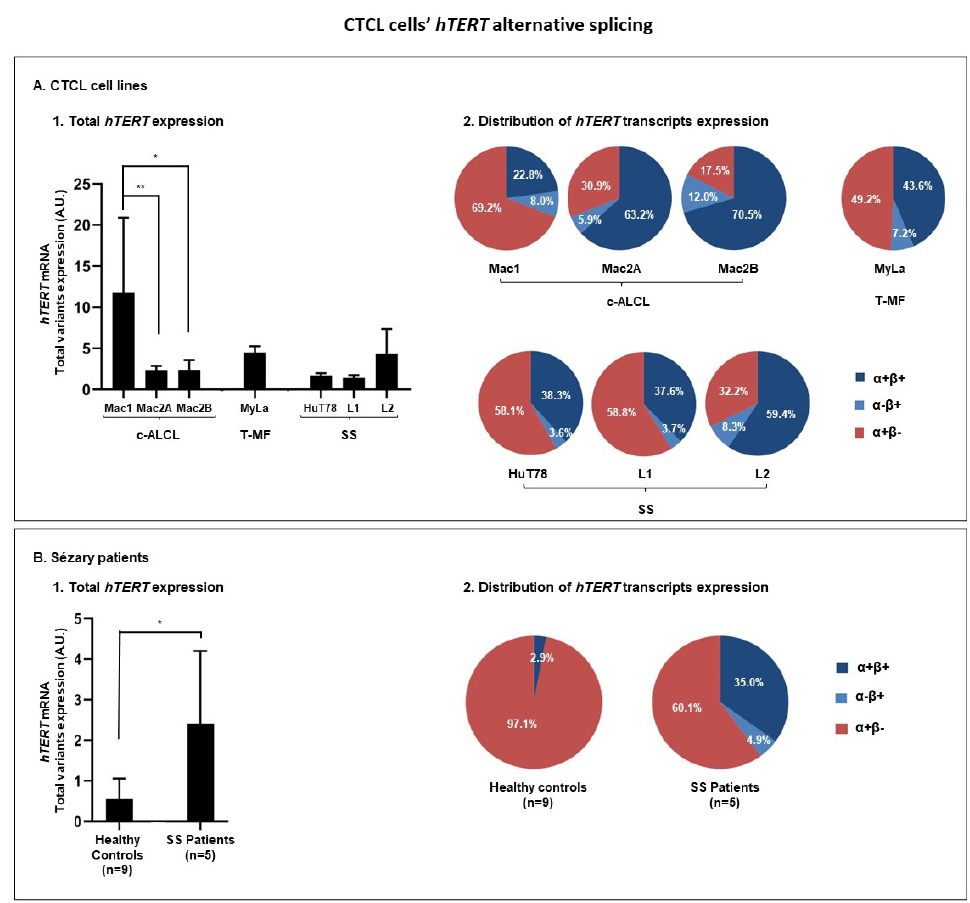
Figure 3. CTCL cells’ hTERT alternative splicing. ( A ) hTERT RT domain transcriptome analyzed in CTCL cell lines representative of different CTCL subtypes: Mac1, Mac2A, and Mac2B for c-ALCL, MyLa for T-MF, and HuT78, L1 and L2 for SS. ( A1 ) hTERT transcripts expression levels. ( A2 ) Distribution of hTERT transcripts expression. β + variants are presented in blue and β - variants in red. ( B ) hTERT RT domain transcriptome analyzed in peripheral blood mononuclear cells from five SS patients, in comparison with nine healthy controls. ( B1 ) hTERT transcripts expression. ( B2 ) Distribution of hTERT transcripts expression. β + variants are presented in blue and β - variants in red. A.U.: arbitrary unit; CTCL: cutaneous T-Cell lymphomas; c-ALCL: primary cutaneous anaplastic large cell lymphomas; T-MF: transformed mycosis fungoides; SS: Sézary syndrome; hTERT : human telomerase